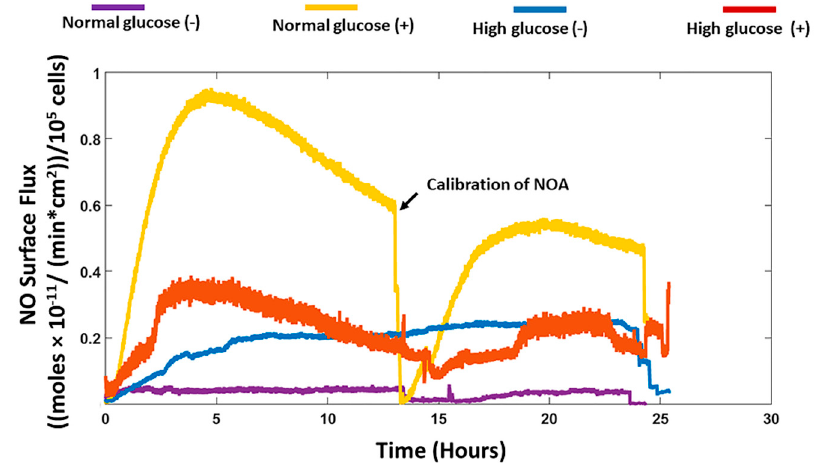
Figure 1. An example of real-time nitric oxide (NO) surface flux (normalized to the cell number) generated from HDFa with (+) and without ( − ) stimulation cultured under normal (5.5 mM) and high glucose (25 mM) conditions measured with chemiluminescence detection using a CellNO trap.